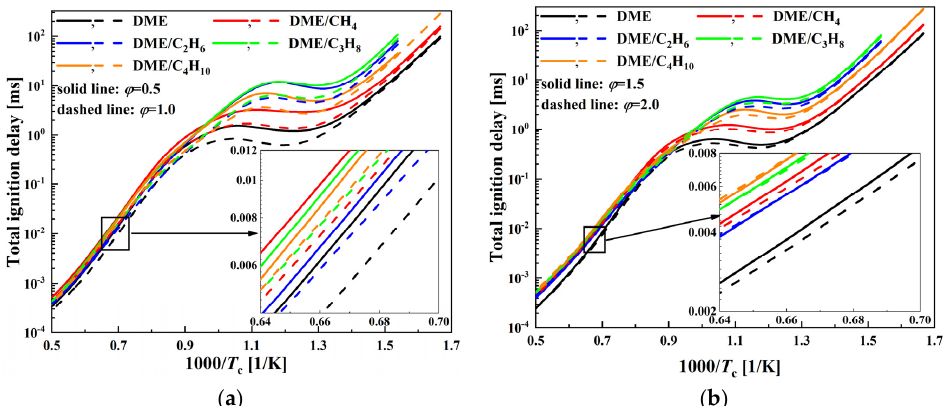
Figure 1. Comparison of ignition delay of DME/C1-C4 alkane mixtures for various equivalence ratios at P c = 20 bar: ( a ) ϕ = 0.5, 1.0 and ( b ) ϕ = 1.5, 2.0.